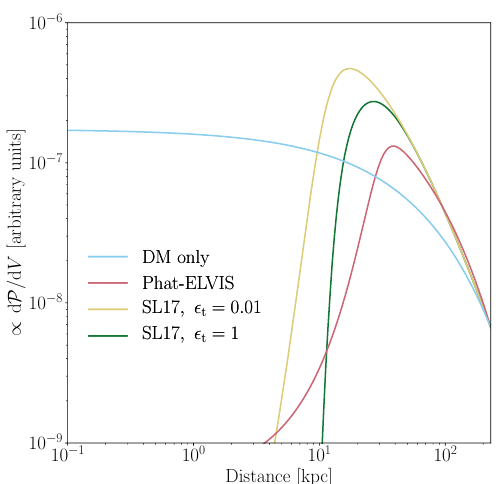
Figure 2. The four spatial PDFs of subhalos considered in this work: SL17 models for subhalos with m > 10 6 M (yellow and green), PDF based on the Phat-ELVIS simulation (red) [10], and on (cid:12) the Aquarius simulation (blue) [74]. To highlight the behavior at low radii where tidal effects are the most relevant, the curves are shifted to match the value of d Phat-ELVIS